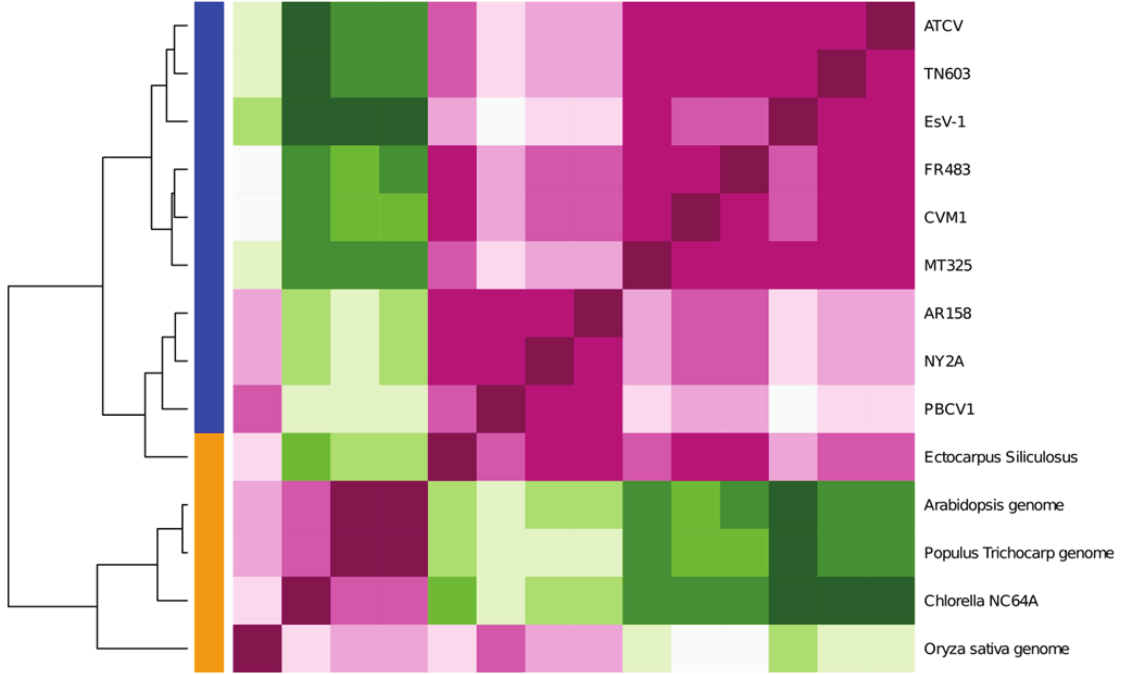
Figure 4. Clustering by the entropy-variability distance of Equation (1) for the extended genomic sequence set. We show the distance matrix d ( p,q ) for any genomic sequence pair- ing ( p,q ) for each genomic sequence with respect to each sequence (center plane, red = small values, green = high values). The bar on the left indicates whether the sequence is of viral origin (blue) or a living organism (orange). Note that the tree is not